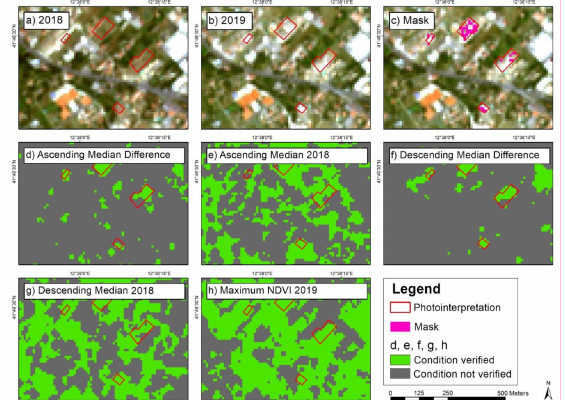
Figure 7. Land consumption example related to buildings and infrastructures. Images ( a ) and ( b ) show the Sentinel-2 image for 2018 and 2019; image ( c ) reports the potential change identified by the mask; images ( d – h ) indicate the areas where the considered conditions are verified (green) and not verified (grey). The information related to the slope is not shown, as the whole area illustrated has a slope of